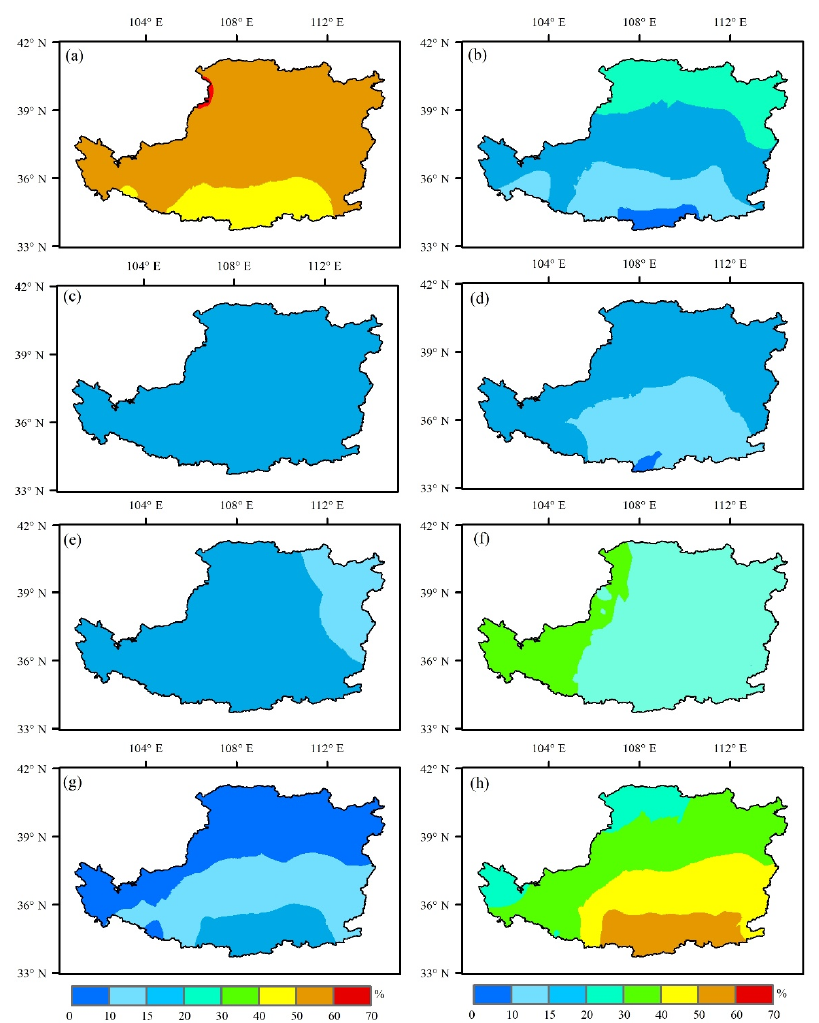
Figure 5. Spatial distribution of the (left column) incidence and (right column) contribution rates in ( a , b ) prompt-duration; ( c , d ) short-duration; ( e , f ) moderate-duration and ( g , h ) long-duration events, respectively.